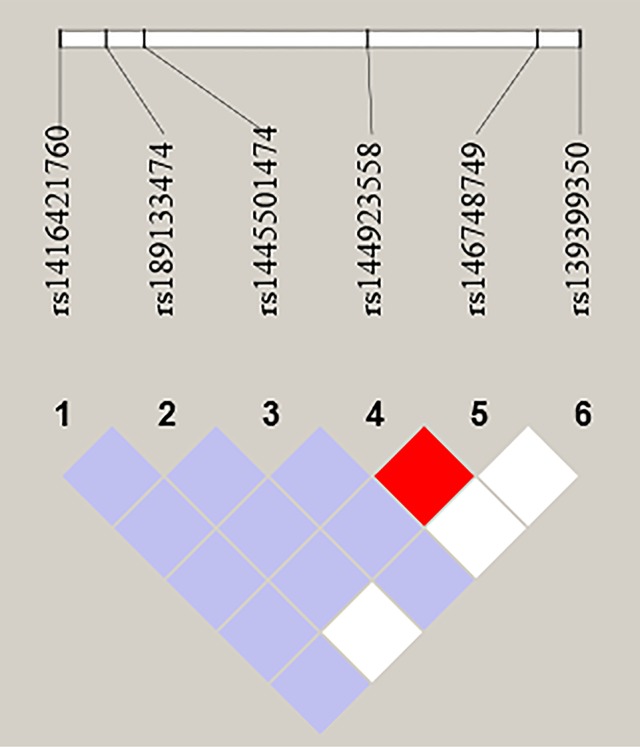
LD analysis of the six SNPs in AMI. Standard color schemes indicate different levels of LD. Bright red: LOD > 2, D' = 1; Purple: LOD < 2, D' < 1; White: LOD < 2, D' < 1; LOD: Log of the odds of there being LD between two loci.